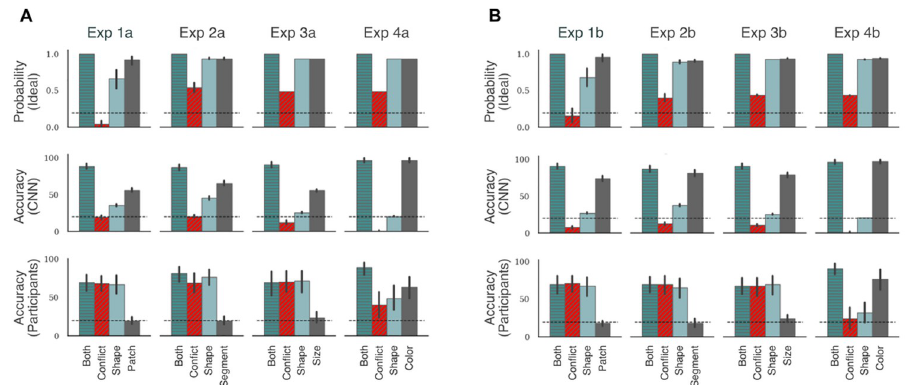
Fig 3. Results in Experiments 1–4. Each column corresponds to an experiment and each row corresponds to the type of learner (ideal inference model, CNN or human participants). The top row shows the posterior probability of choosing the labelled class for a test trial given the training data. The bottom two rows show categorisation accuracy for this labelled class. Panel A shows results for experiments where both features are equally predictive (1a, 2a, 3a and 4a), while Panel B shows results for experiments where the non-shape feature is more predictive (1b, 2b, 3b and 4b). Each plot shows four bars that correspond to the four types of test trials. Patch , Segment , Size and Colour refer to the Non-shape test trials in Experiments 1, 2, 3 and 4, respectively. Error bars show 95% confidence and dashed black line shows chance performance. In any plot, a large difference between the Both and Conflict conditions shows that participants rely on the non-shape cue to classify stimuli. Both models show this pattern while humans show no significant difference.